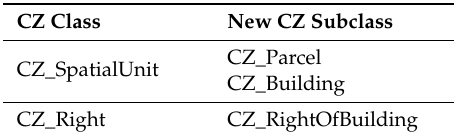
Table 2. The newly-added CZ subclasses for the Czech cadastral profile.